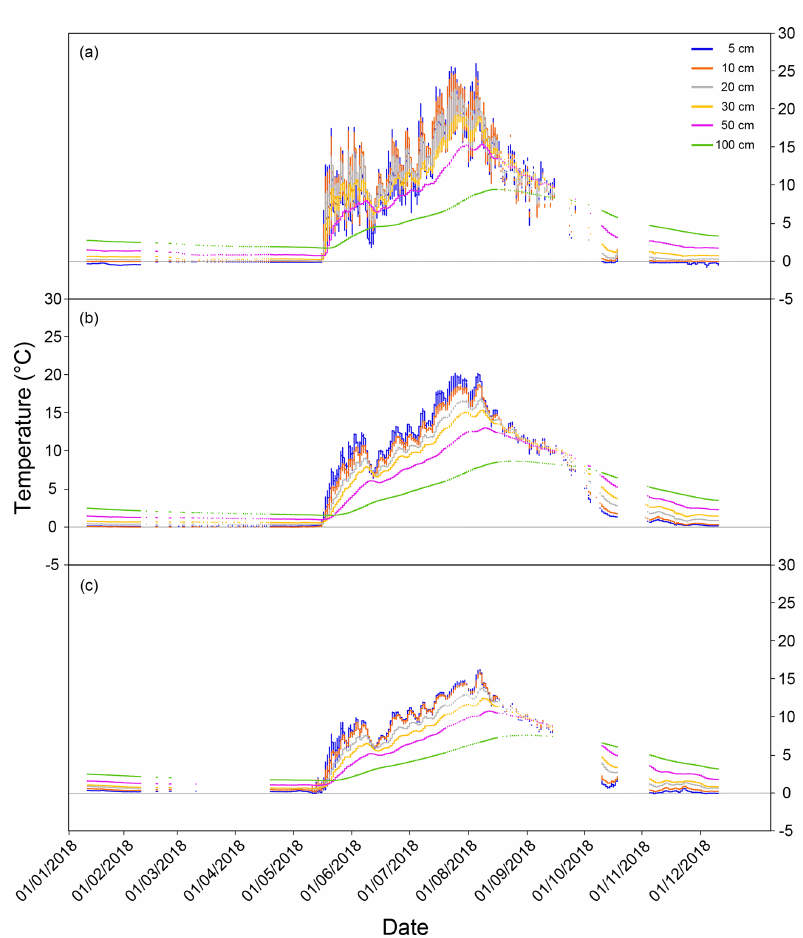
Figure A1. Continuous peat temperature (at 5, 10, 20, 30, 50, and 100cm depth below the surface) in 2018 at Lompolojänkkä at measuring points, (a) far from the stream, (b) an intermediate distance from the stream, and (c) in the stream. A detailed description of the locations of the sample points can be found in Fig. 1.